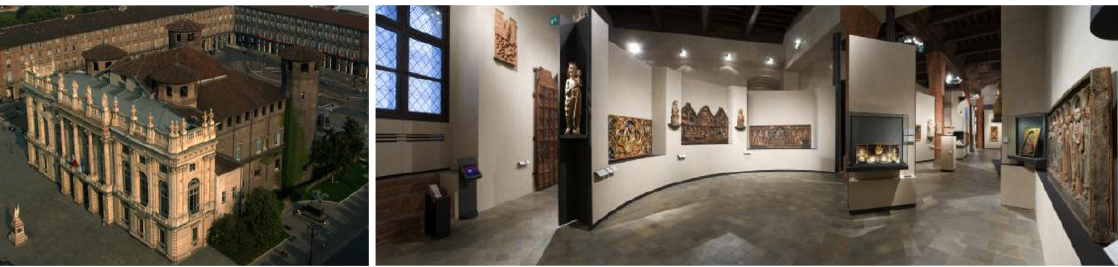
Figure 4. An image of Palazzo Madama ( left ) and of one of its venues ( right